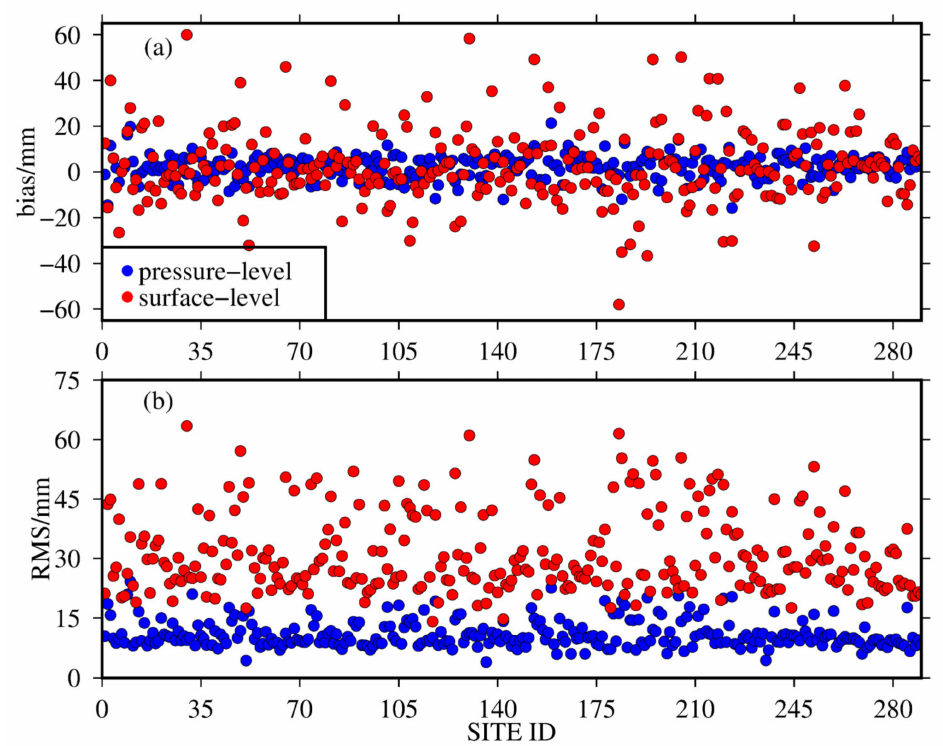
Figure 3. ( a ) Bias and ( b ) RMS of ERA5 ZTD from pressure- and surface-level data compared to GNSS ZTD at 290 stations from 2016 to